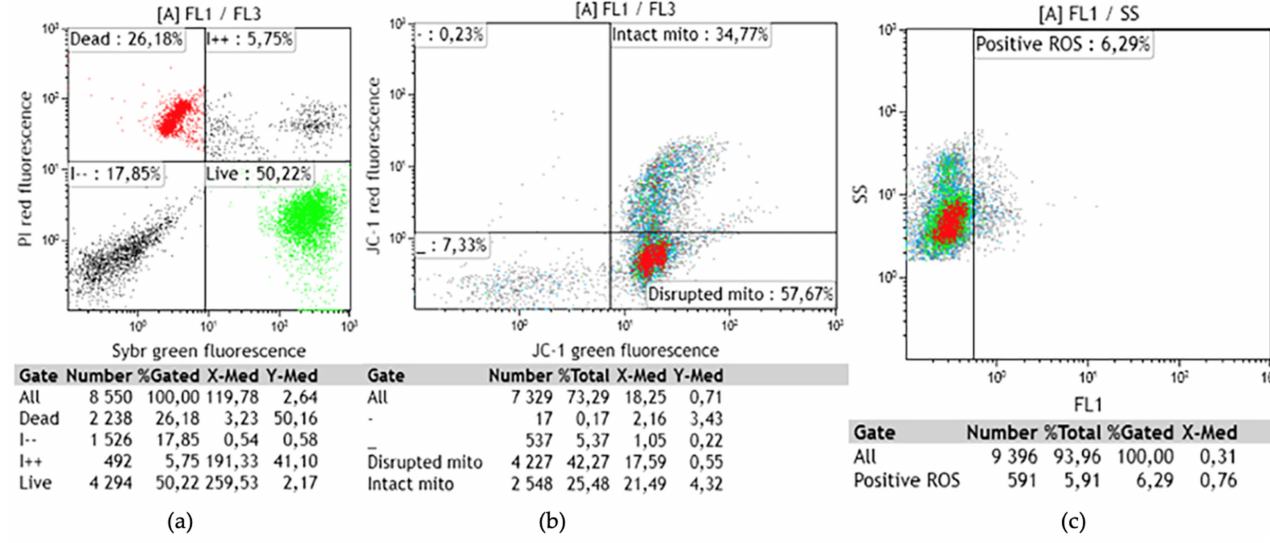
Figure 4. Flow cytometric forward scatter gated analysis on one sample of post-thaw bovine sperm quality for viability ( a ); mitochondrial membrane potential ( b ); and ROS ( c ) (LSM ± SE) levels. ( a ) SYBR-14 and PI viability stain. Red dots represent dead sperm, green dots represent viable or live sperm, out-gated red/green dots represent recently moribund or membrane damaged sperm, and unstained dots represent debris with low fluorescence. ( b ) JC-1 mitochondrial membrane potential: Populations of sperm with high mitochondrial membrane potential (intact) with fluorescence shift from green to red, and low mitochondrial membrane potential (disrupted) with fluorescence intensity shift from red to green. ( c ) ROS levels using 2, 7-diclorodihydrofluorescein diacetate (H2DCFDA) dye, which de-esterified and fluoresced upon